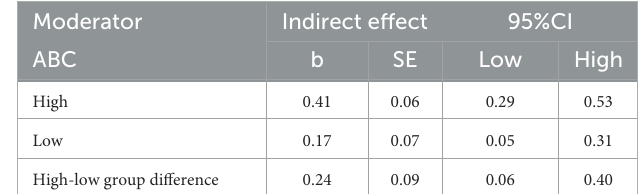
TABLE 4 Mediating effect of organizational-based self-esteem on different levels of anxiety based on